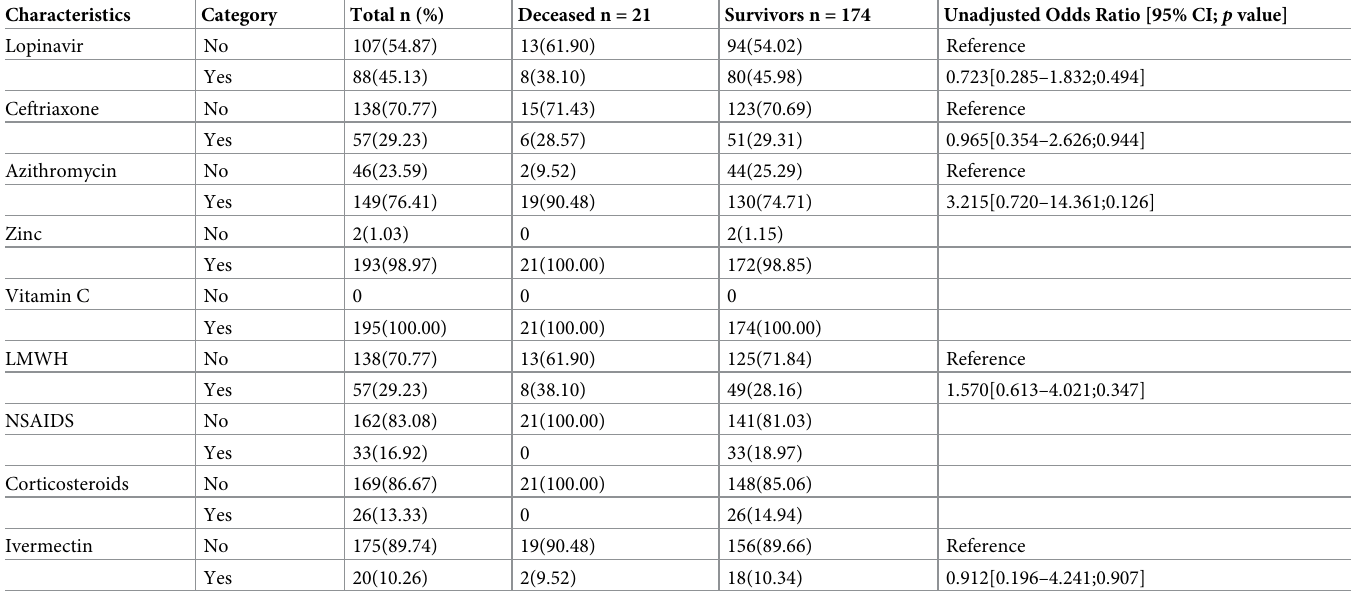
Table 4. Treatment and univariate analysis of mortality risk factors of COVID-19 patients (N = 195) at Kwanar Dawaki isolation center, Kano, Nigeria.